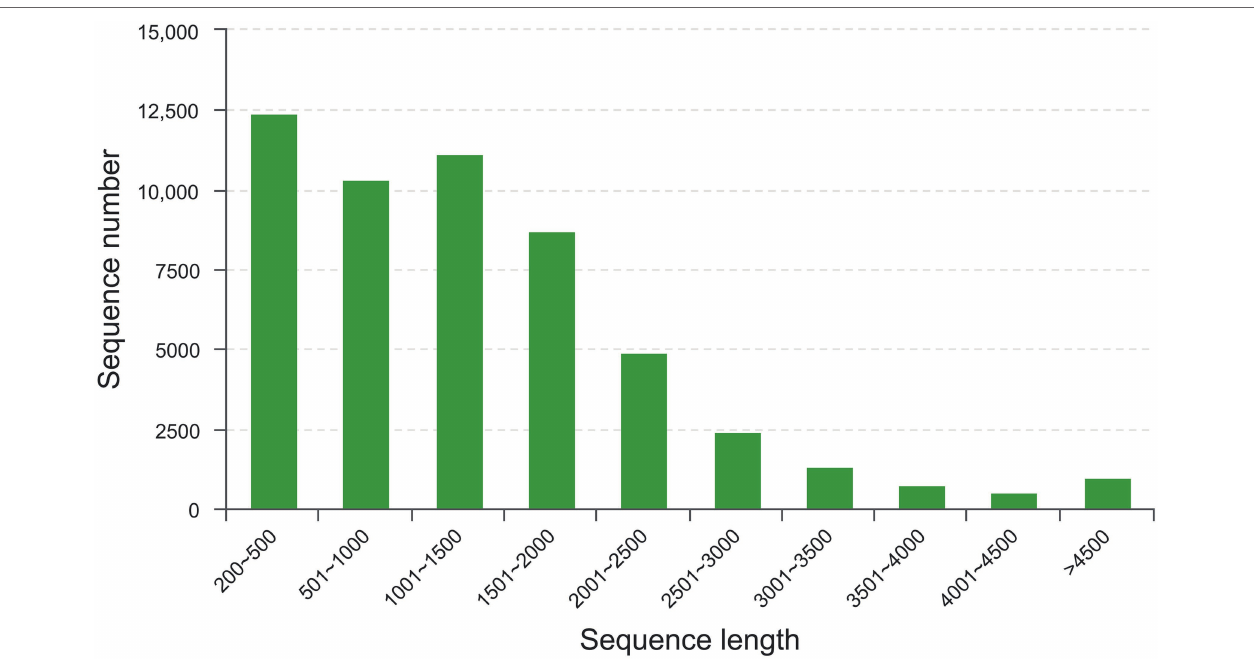
FIGURE 4 | The length distribution of unigenes. X-axis, sequence length; Y-axis, sequence number for corresponding sequence length.